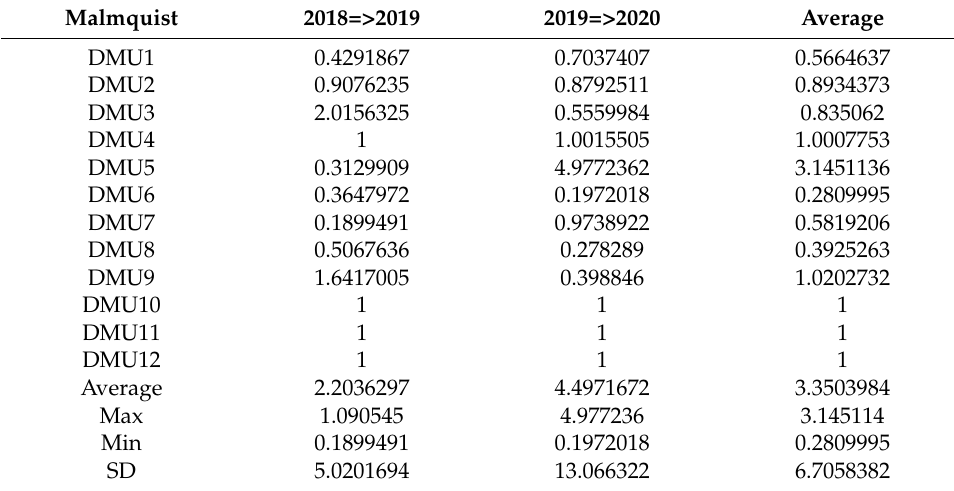
Table 14. The Malmquist productivity index changes level over the period from 2018 to